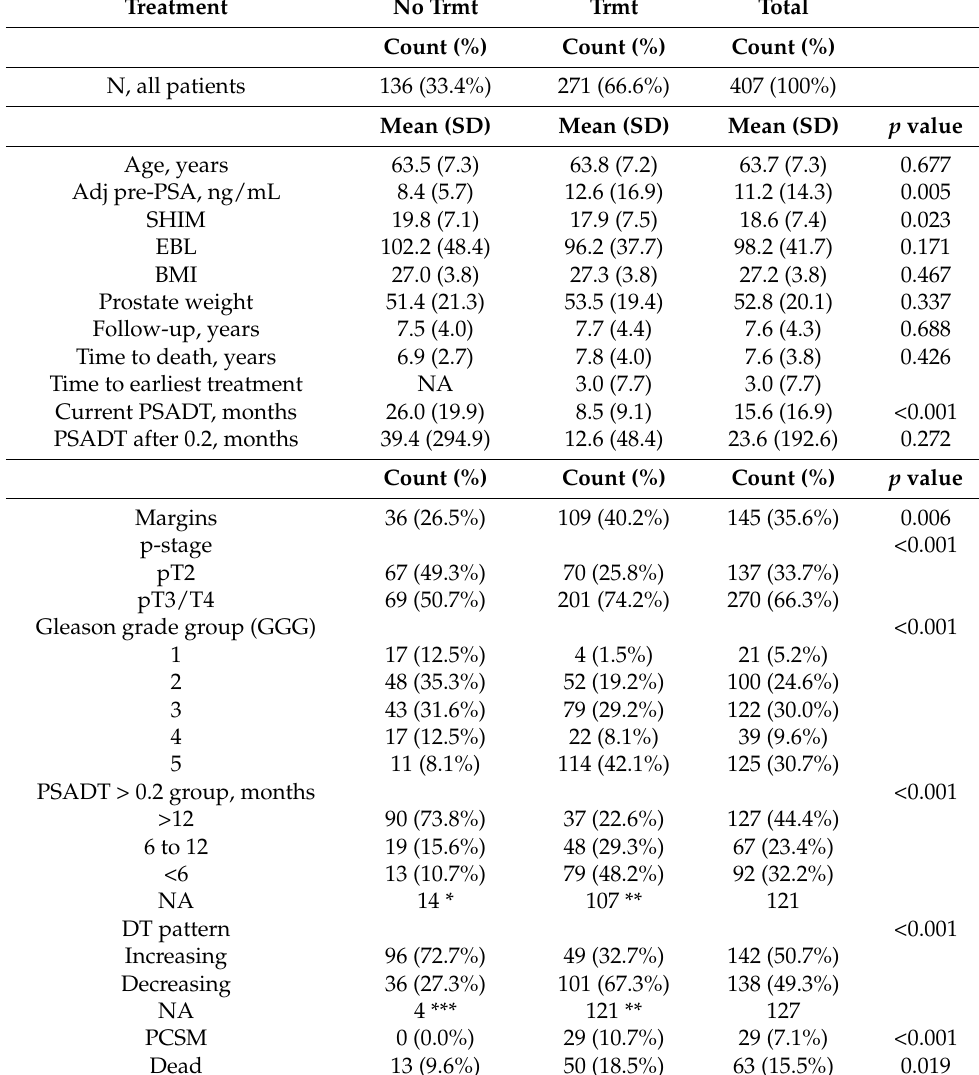
Table 1. Demographics of BCR patients in the AO (N = 136) and treatment ( n = 271) groups. Treatment No Trmt Trmt Count